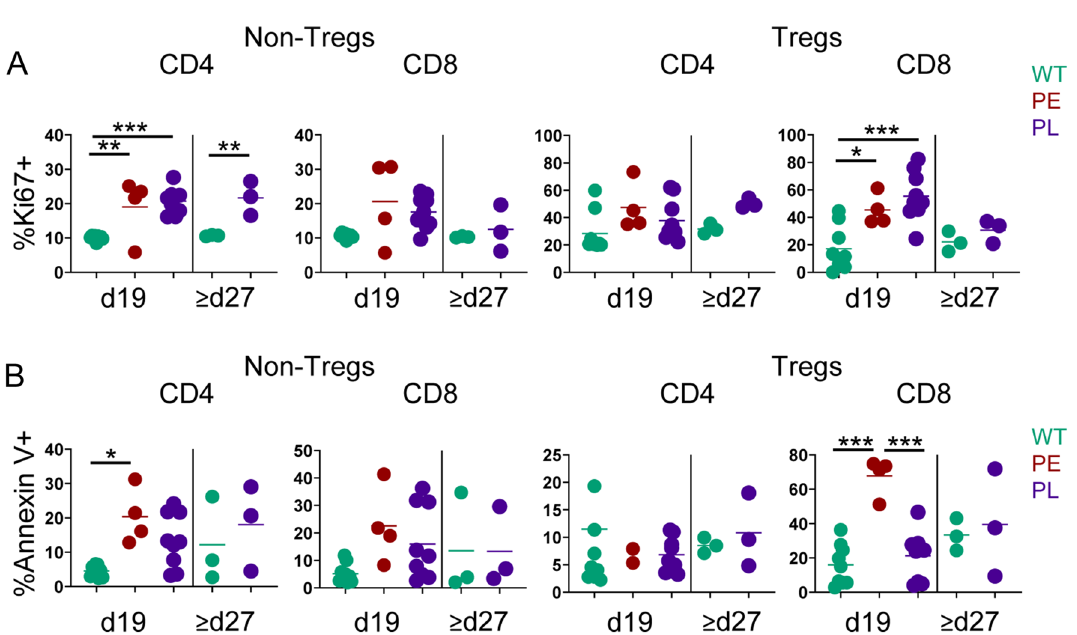
Figure 7. IL-2Rα-KO T cells exhibit differential proliferation and apoptosis. Frequency of ( A ) Ki67+ or ( B ) annexin V+ 19-day-old and late endpoint (d27+) WT and IL-2Rα-KO T cells from the spleen are shown. n = 3–9 mice per experimental group. Statistics: one-way ANOVA with Benjamini–Hochberg FDR correction; *p < 0.05, **p < 0.01, ***p < 0.001. Non-significant comparisons are not